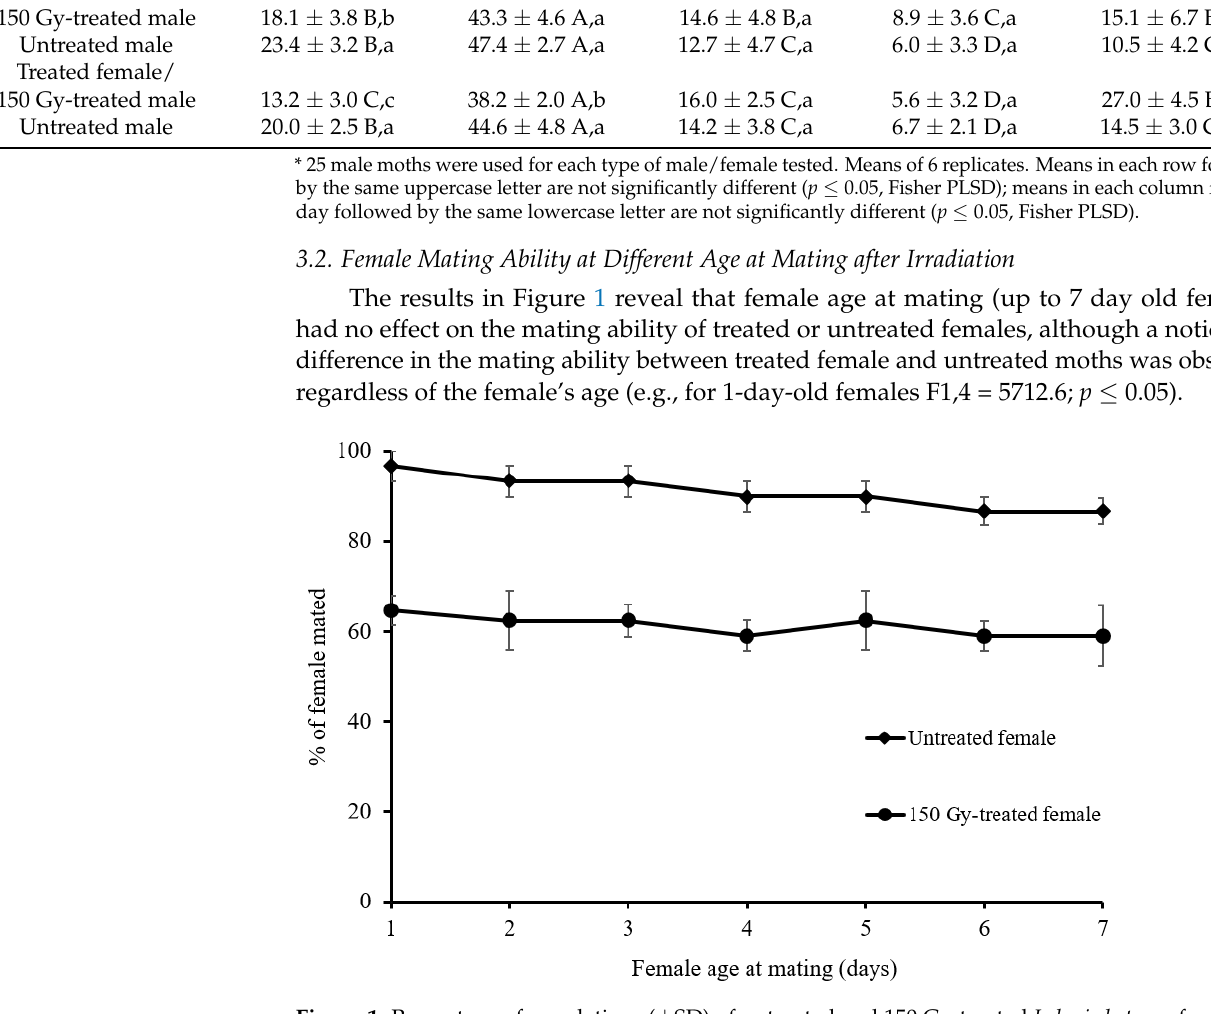
Figure 1. Percentage of copulations ( ± SD) of untreated and 150 Gy-treated Lobesia botrana females of different ages with untreated virgin males.